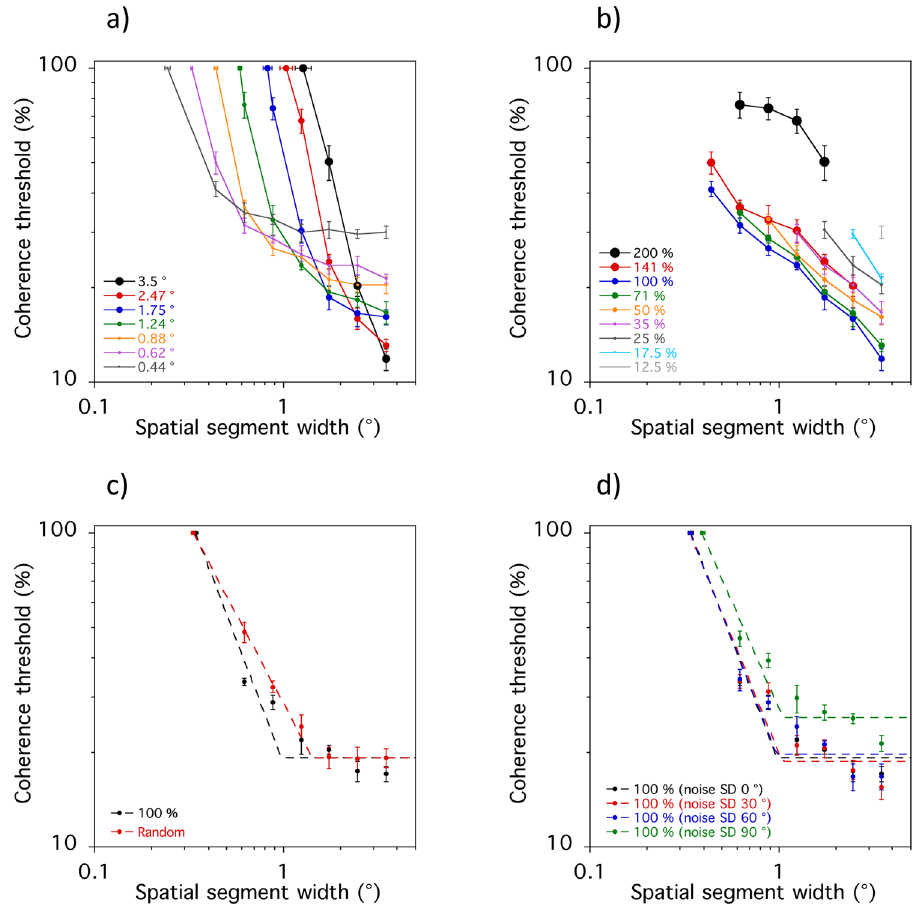
Figure 6. Results of the computational analyses. The graphs display acuity limits and coherence thresholds as a function of segment size when integration area is either fixed ( a ) or varied in proportion to segment size ( b ). Upper and lower bounds on field size were introduced to constrain the analyses and produced a qualitatively similar pattern of performance to that associated with poor reading when integration field size was randomised (sub-optimal) on each trial ( c ), but not when internal noise levels were elevated ( d